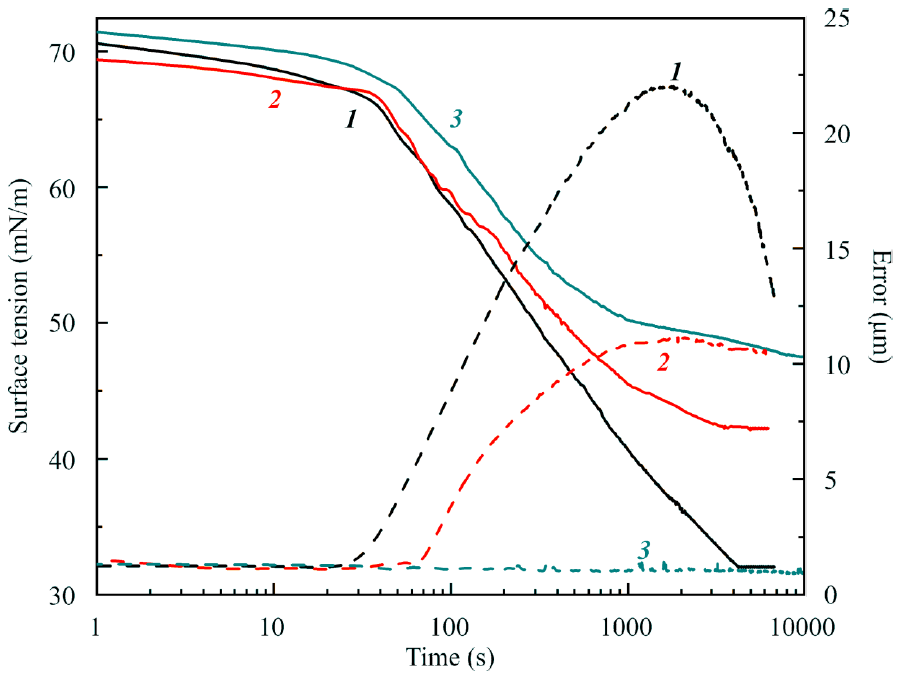
Figure 9. The same as in Fig. 8 for a capillary of 3 mm in diameter, initial drop volume 24 mm 2 , surface area 34 mm 2 and three different solution concentrations: 1 , 1; 2 , 2; and 3 , 5 μmol/L.